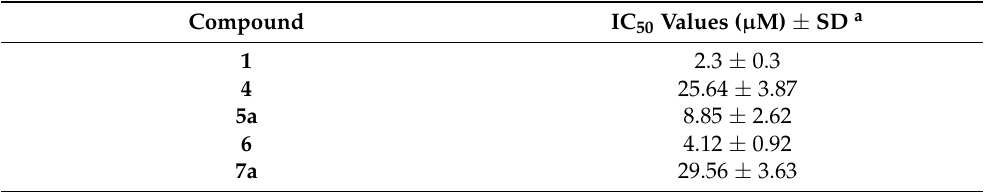
Table 2. Inhibition of cell growth for quinazoline derivatives from three independent experiments in A431 cancer cell